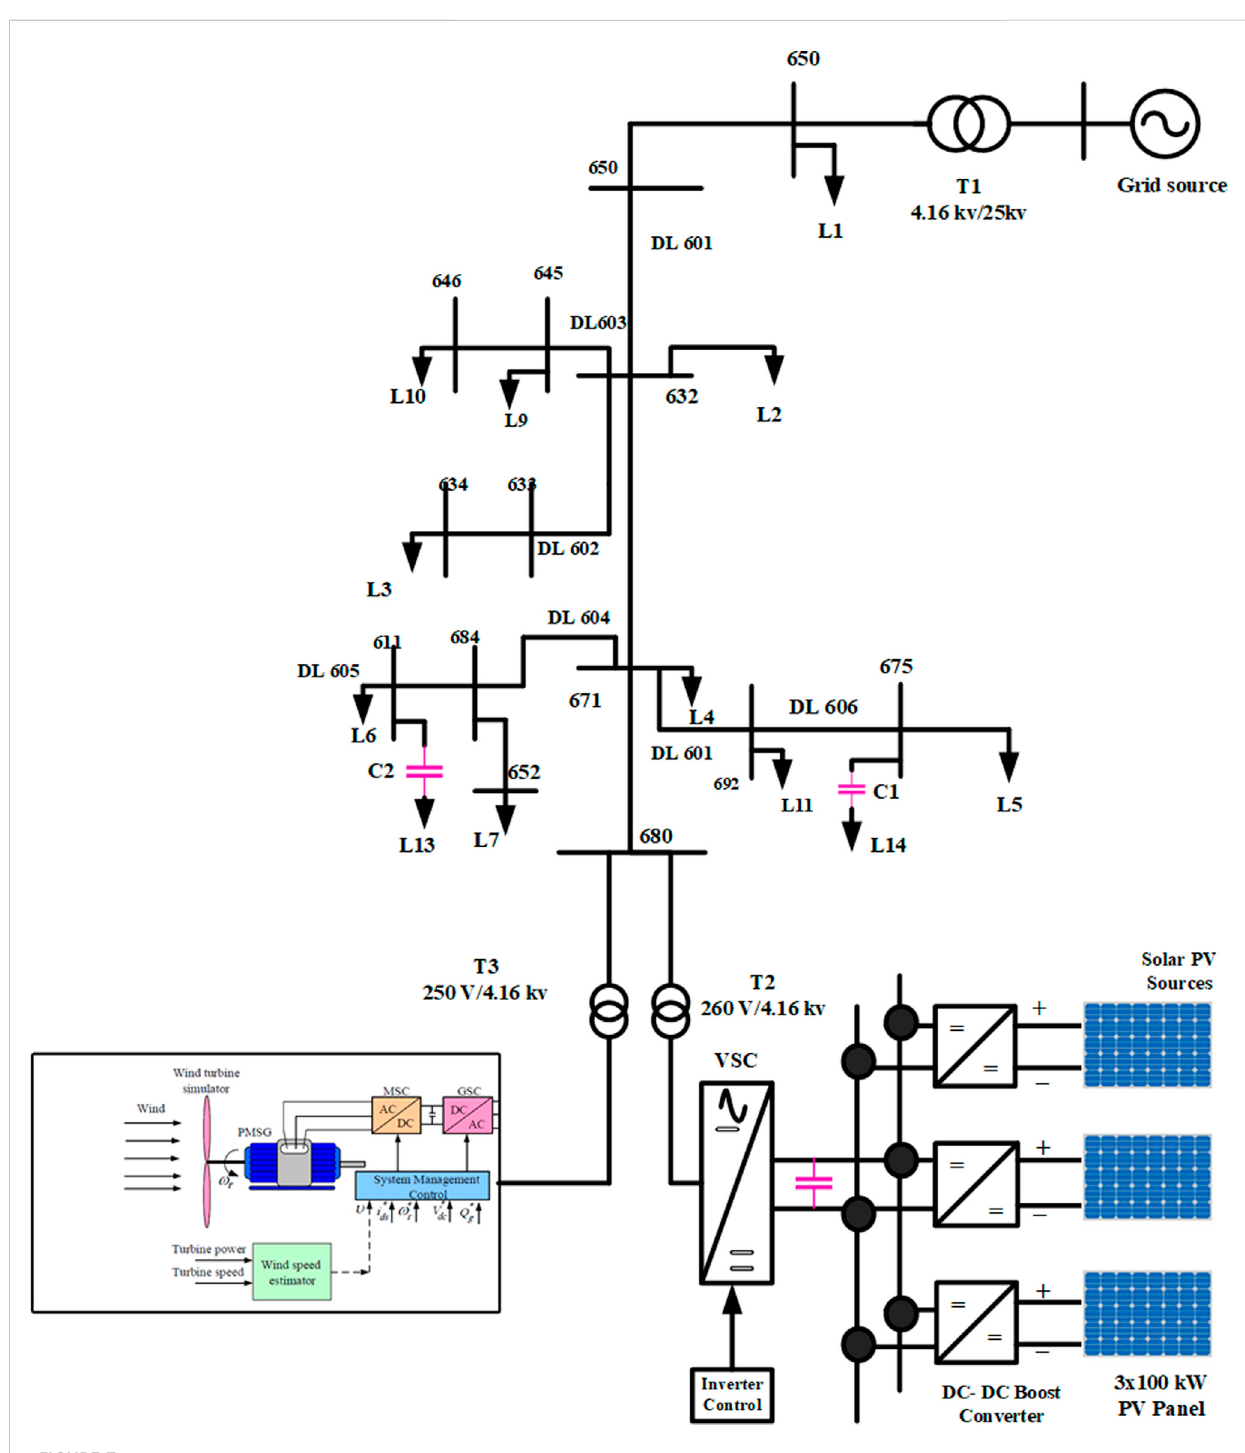
FIGURE 7 IEEE-13 Bus system with the solar PV system & WECS (Mishra and Yadav, 2019).